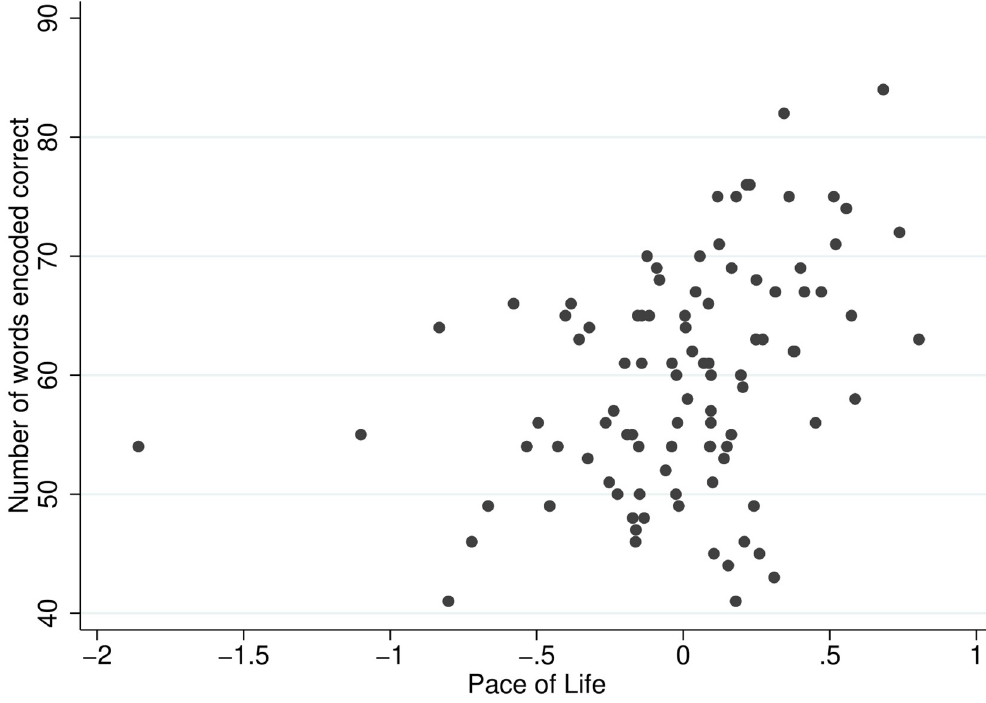
Fig 4. Two-way scatter plot: Words encoded correctly and Pace of Life